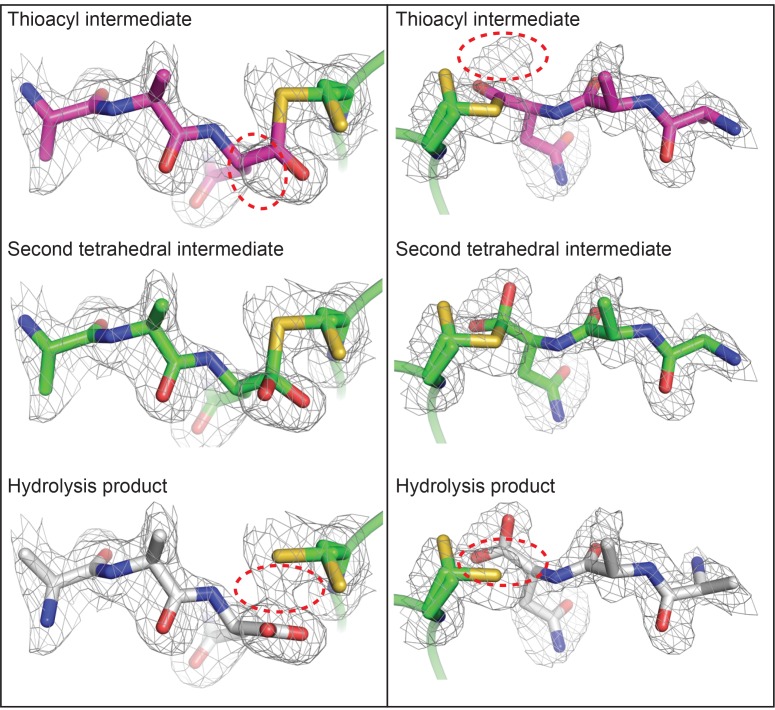
Polder OMIT maps define the presence of a tetrahedral intermediate in the HaAEP1 active site.Polder OMIT maps (Fobs - Fcalc) calculated in the absence of an AAN peptide ligand, contoured at 3σ level, indicate that models of alternative intermediate AAN peptide structures (thioacyl intermediate – purple) and cleavage product (hydrolysis product – gray) appear not to fit the observed electron density as well as the modeled tetrahedral intermediate (second tetrahedral intermediate – green). Model peptides are shown from above (left) and side on (right) to aid visualization of electron density maps with incongruous regions of models circled (red dashed line).